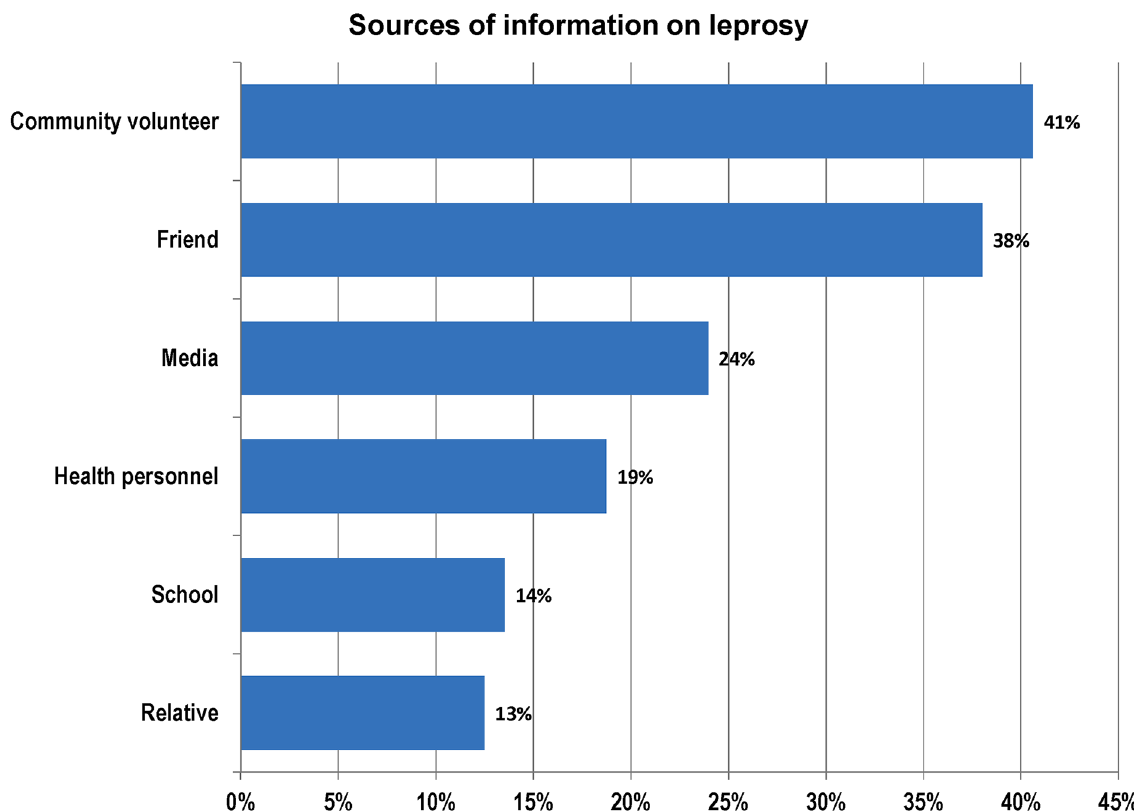
Fig 3. Sources of information on leprosy. The major sources of information on leprosy to our participants were from community volunteers (41%), friends (38%), the media (24%), and health personnel (19%).